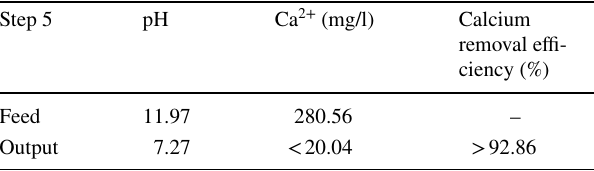
Table 5 Results of consecutive rinsing-crystallization cycles Table 6 Results of fifth step of the ettringite precipitation process using CO